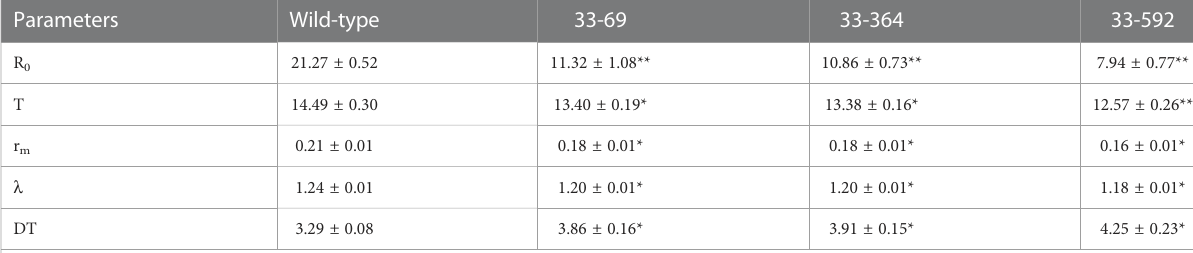
TABLE 1 Life table parameters of grain aphids fed on wild-type and different transgenic wheat lines.